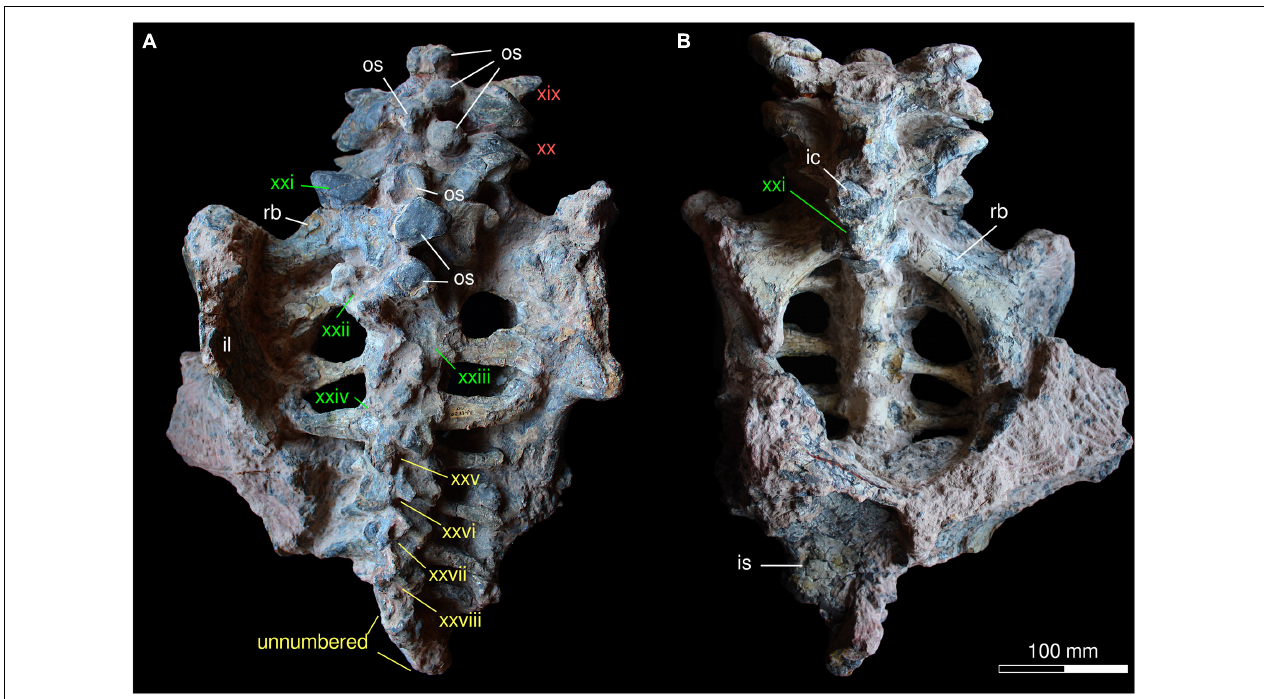
FIGURE 8 | Posterior axial skeleton of Provelosaurus americanus , UFRGS-PV-0233-P, in (A) dorsal and (B) ventral views. ic, intercentrum; il, ilium; is, ischium; os, osteoderm; rb, rib; xix–xxviii, vertebrae numbers (red, dorsals; green, sacrals; yellow, caudals).